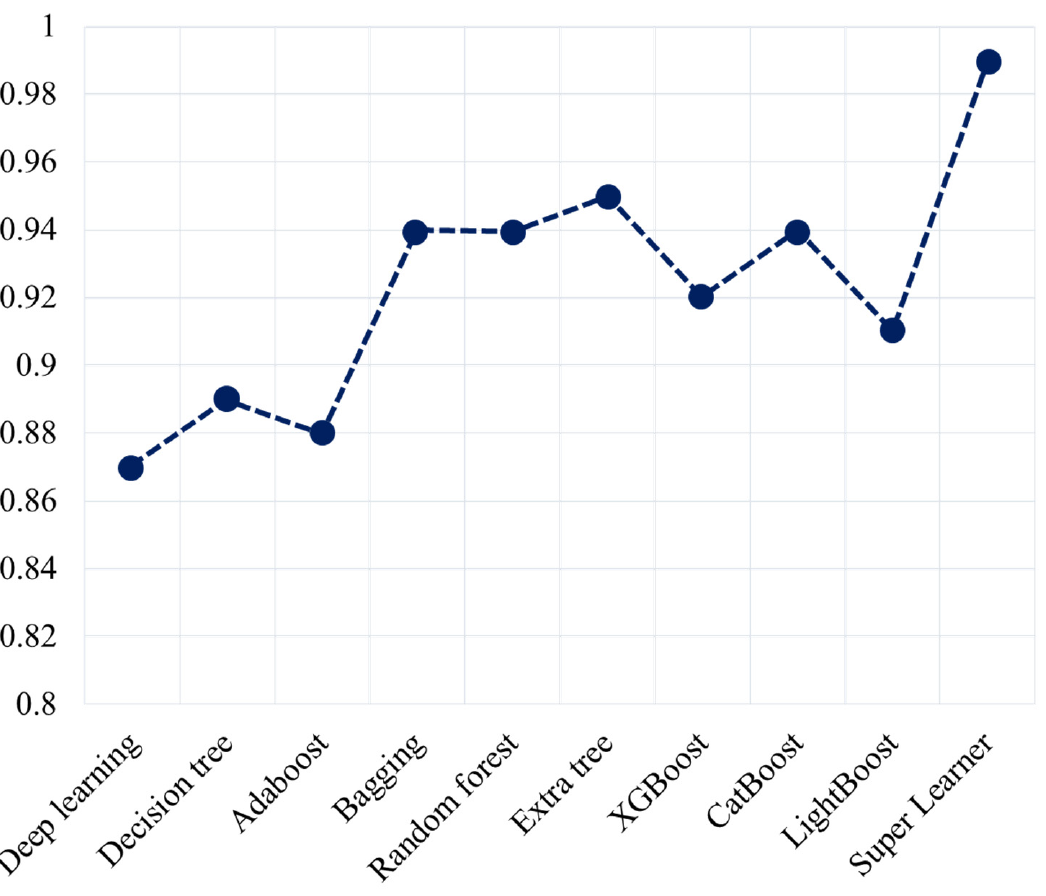
Figure 14. Comparison of correlation coefficient results of all machine learning models used in this study.